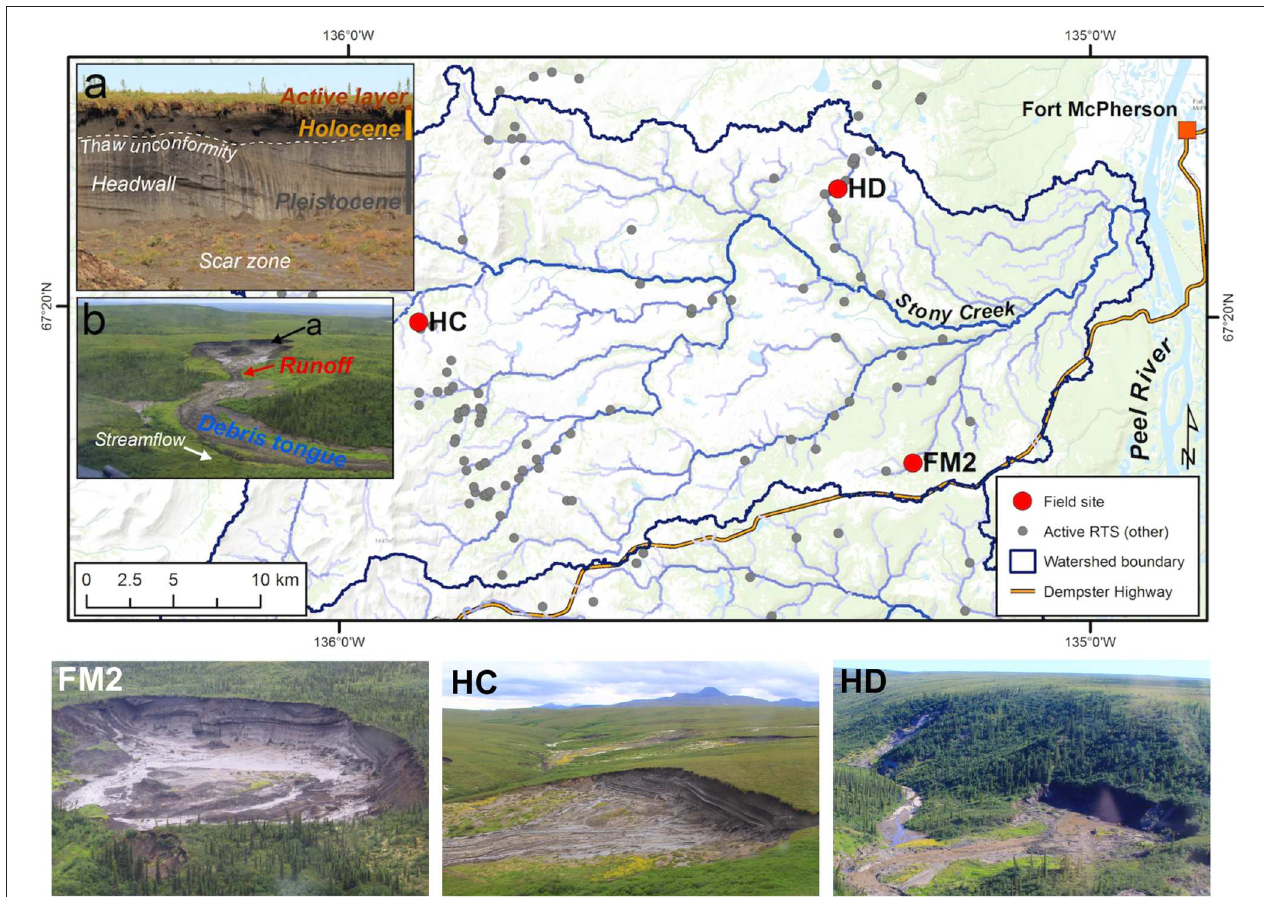
FIGURE 1 | Map of retrogressive thaw slump (RTS) study sites ( n = 3) on the Peel Plateau (NWT, Canada) from which sediments for the experiment were collected. Sediments were collected from RTS FM2, HC, and HD (see photos below and locations on map). Photos were taken in 2014 (FM2) and 2017 (HC, HD). The photo of FM2 captures its southern lobe only. Insets (a) and (b) depict sampling locations of the five sediment sources (i.e., treatments) detailed in the text. Note location of inset (a) shown in (b). Inset photos depict sediment sources common to all RTS that were sampled for the experiment (RTS in inset photos from this region but not study). Basemap from Esri ArcGIS Online; “Active RTS” points on map from Segal et al.